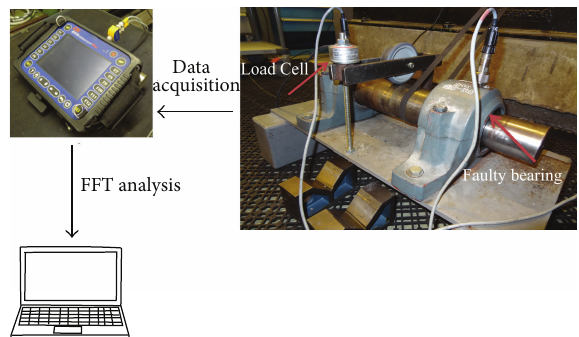
Figure 17: Test setup for bearing defect experiments